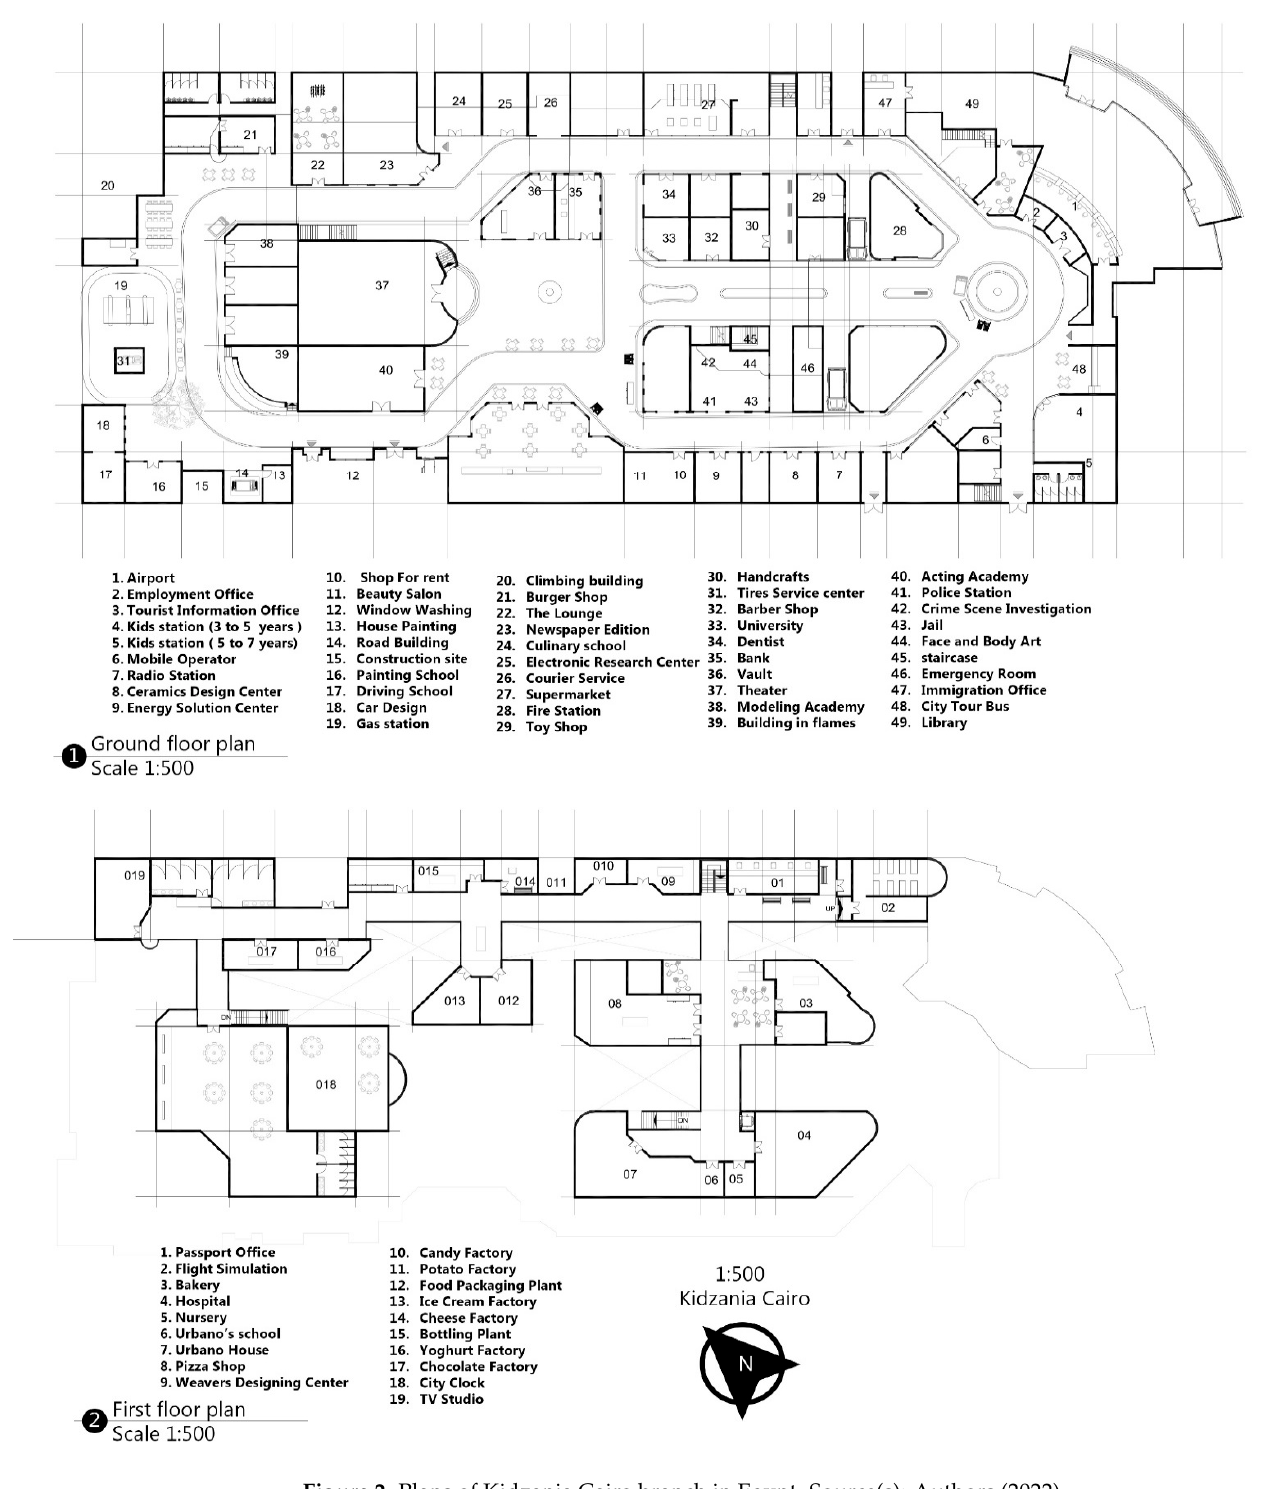
Figure 2. Plans of Kidzania Cairo branch in Egypt. Source(s): Authors (2022). It is an ultra-realistic, kid-sized replica of a city, constructed indoors, and incorporating real-world well-known brands, such as Coca-Cola, Chipsy, CIB, and Egypt Air. Circulation elements inside Kidzania are mainly linear; however, it is subdivided by several nodes and atria which provide vertical connectivity between the different levels. The inner nodes are used to provide entertaining features for the users, and act as magnets to attract users from one node to the